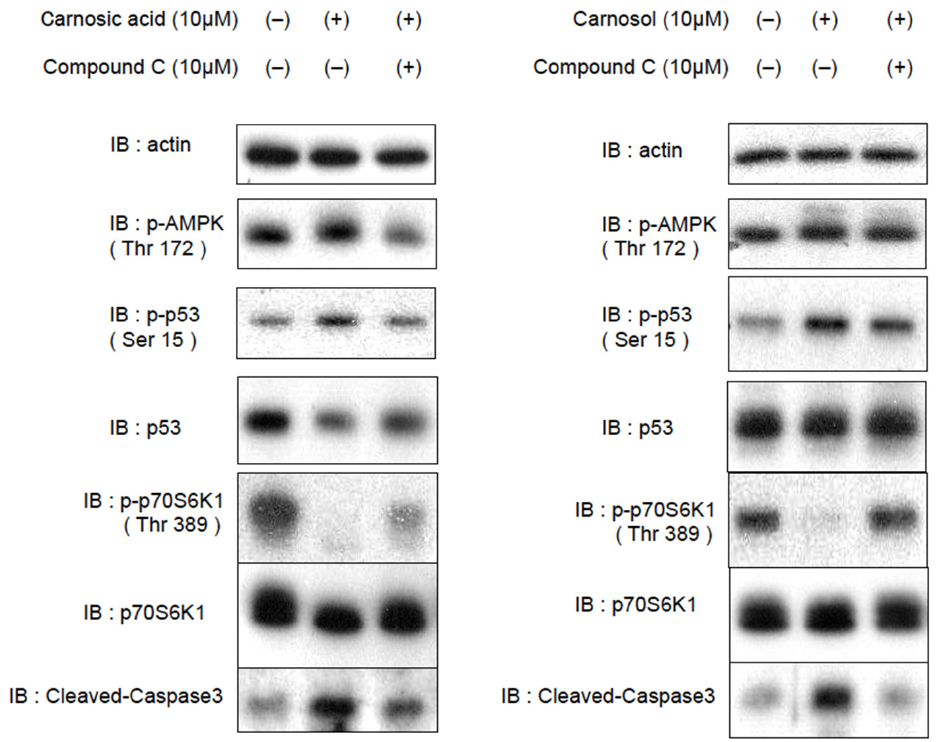
Figure 4. CA and CL activate p53, inhibit the mTORC1-S6K pathway and promote apoptosis in HepG2 cells. After being serum starved for 3 h, HepG2 cells were treated with CA (10 µ M) or CL (10 µ M), with and without CC (10 µ M, 1 h) pretreatment.